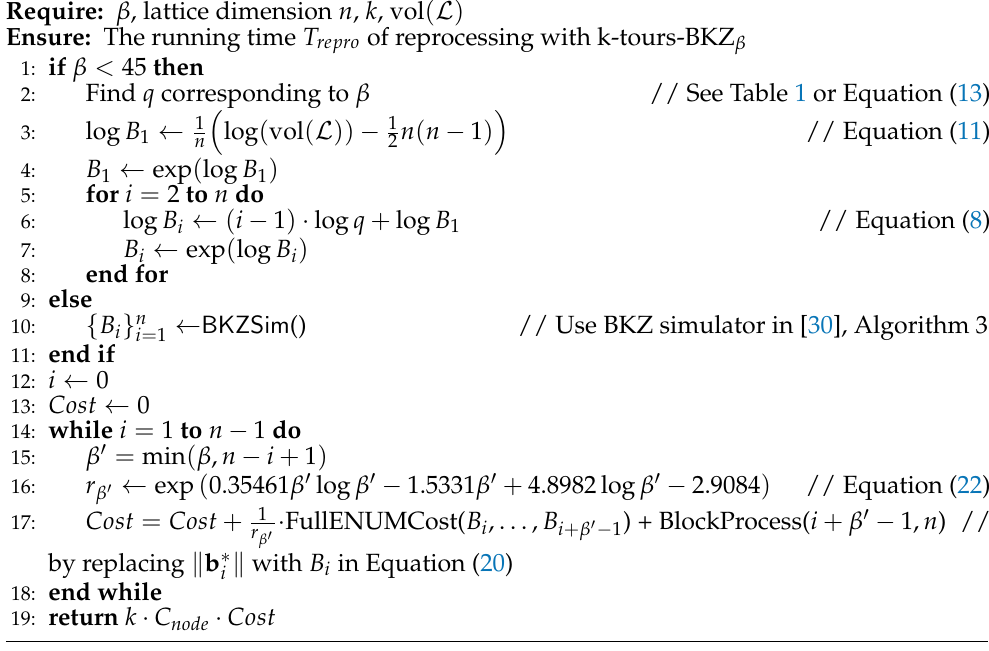
Algorithm 6 Calculating T